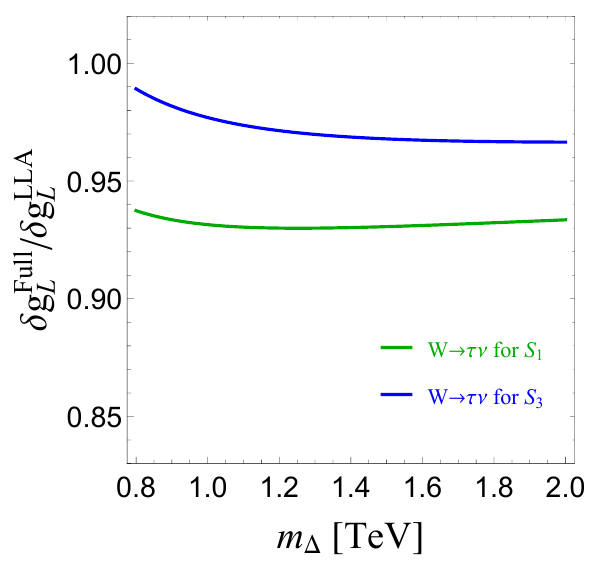
Figure 3 . Comparison of the full expressions given in eq. (4.10) and (4.11) for W obtained by employing a RGE approach with a leading logarithmic approximation (LLA)